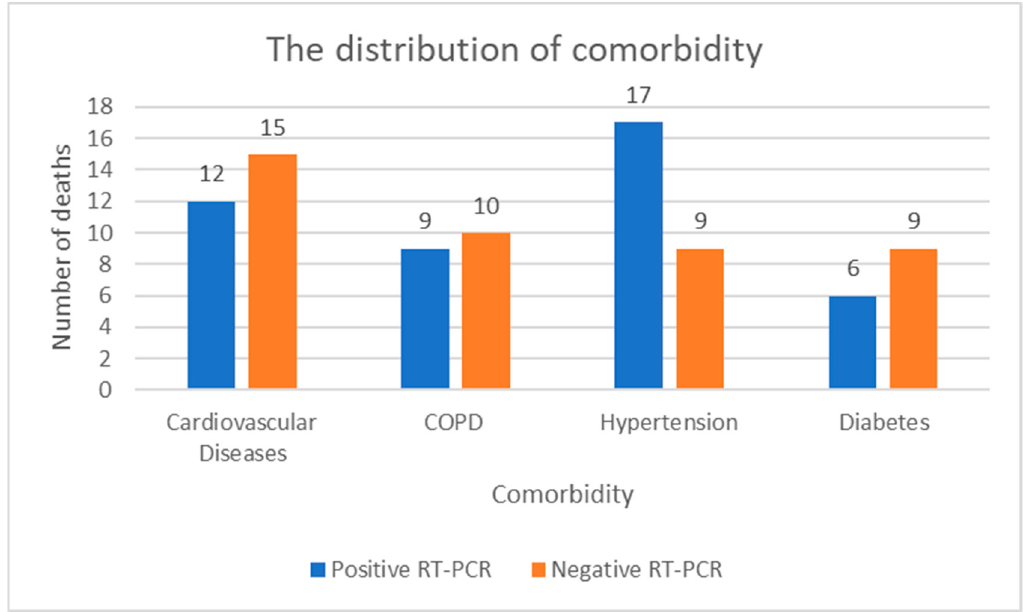
Figure 5. The distribution of comorbidity among the 32 victims with positive RT-PCR (study group #2) and the 28 deaths with negative RT-PCR (cohort #1.1).